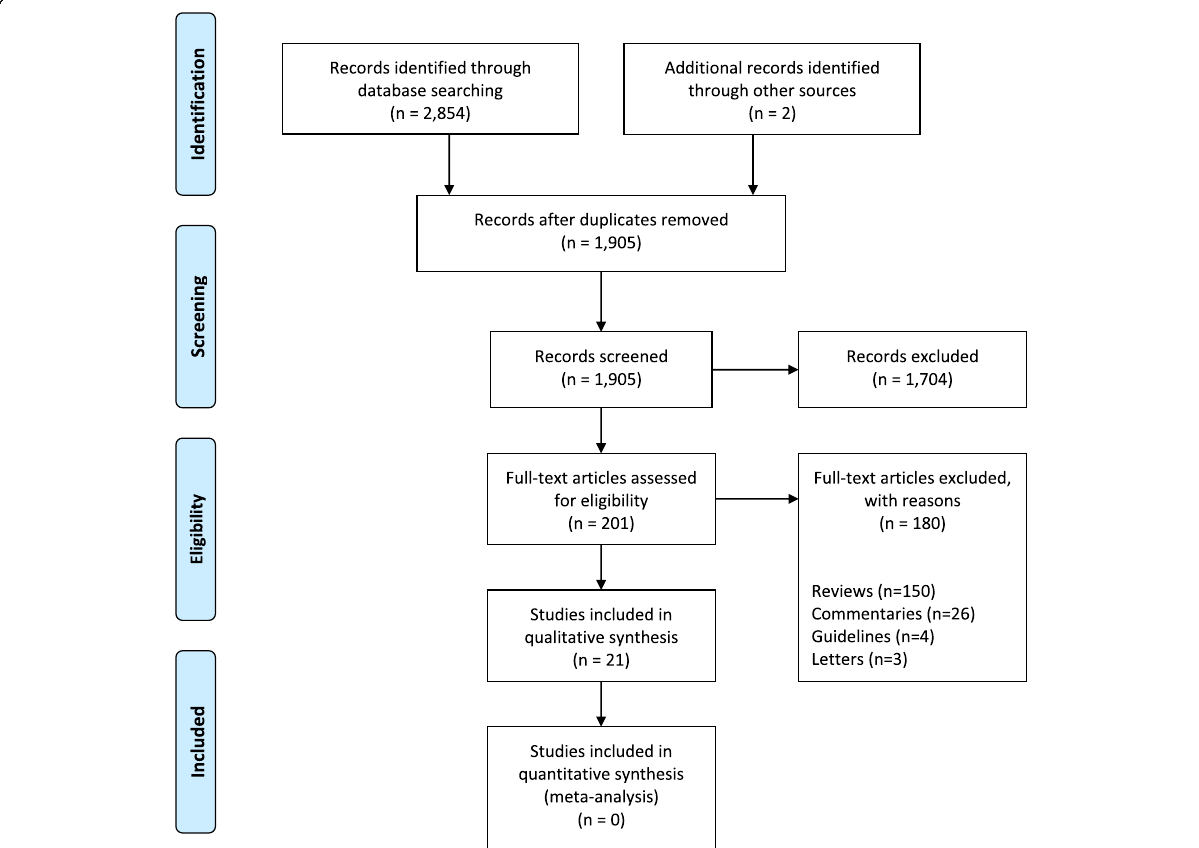
Fig. 1 Flow-chart for the systematic review. Search string: “ migraine AND (hormone OR estrog* OR progest* OR contracept*) ” . Date: